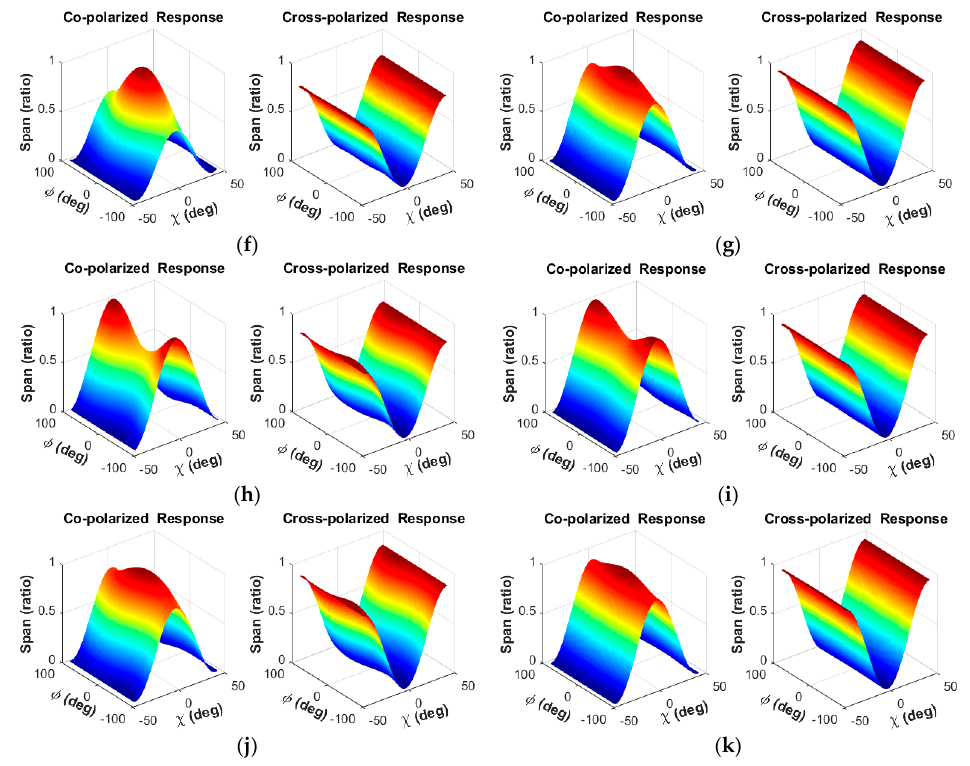
Figure 1. The co-pol and cross-pol response signature of CRs. The signatures show the normalized synthetic span value at different polarization pattern (expressed in a combination of ellipse orientation angel ϕ and ellipticity angle χ ). These charts are: ( a ) theoretical PRS form of a triangular CR; ( b , c ) the PRSs before PolCAL and after PolCAL of image 0002441640; ( d , e ) the PRSs before PolCAL and after PolCAL of image 0002441191; ( f , g ) the PRSs before PolCAL and after PolCAL of image 0002463755; ( h , i ) the PRSs before PolCAL and after PolCAL of image 0002475549; ( j , k ) the PRSs before PolCAL and after PolCAL of image 0002491702. There are two PRS pictures for each image: the left one is the PRSs before calibration, and the right one is the PRSs after calibration.